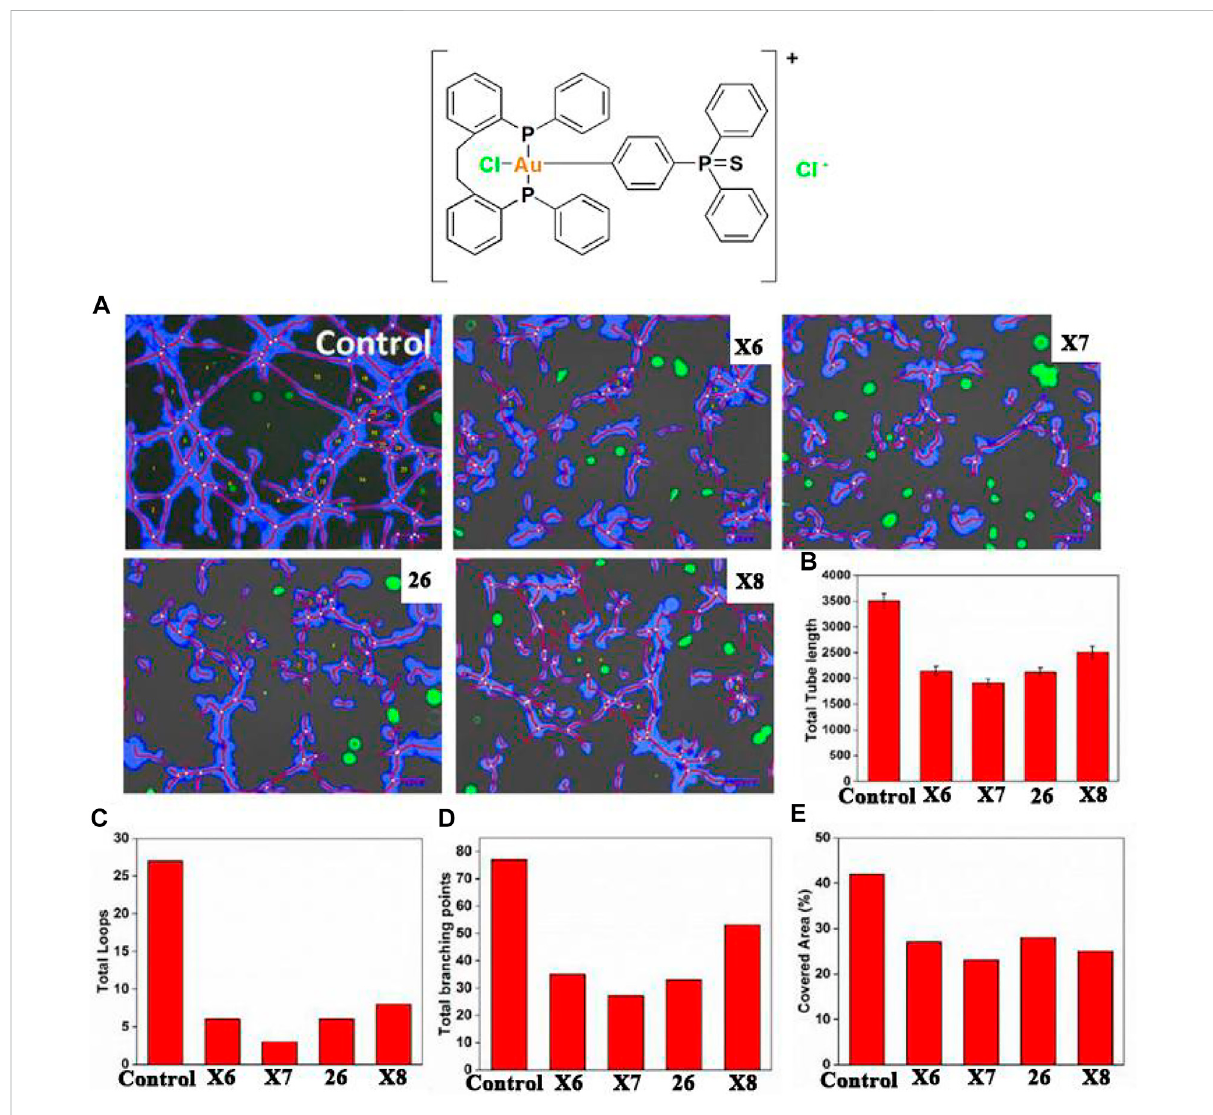
FIGURE 12 Tubeformationsofhumanumbilical vascularendothelial(HUVEC)cells.HUVECscultured onMatrigel-coated platesandtreatedwithgold(III)- phosphine complexes at IC 50 concentrations for 16 h. (A) Tube formation observed by fl uorescence microscopy. (B – E) The total lengths of the branching points, covered area, tubes, and loops were quanti fi ed. Reproduced with permission (Bhargava et al.,